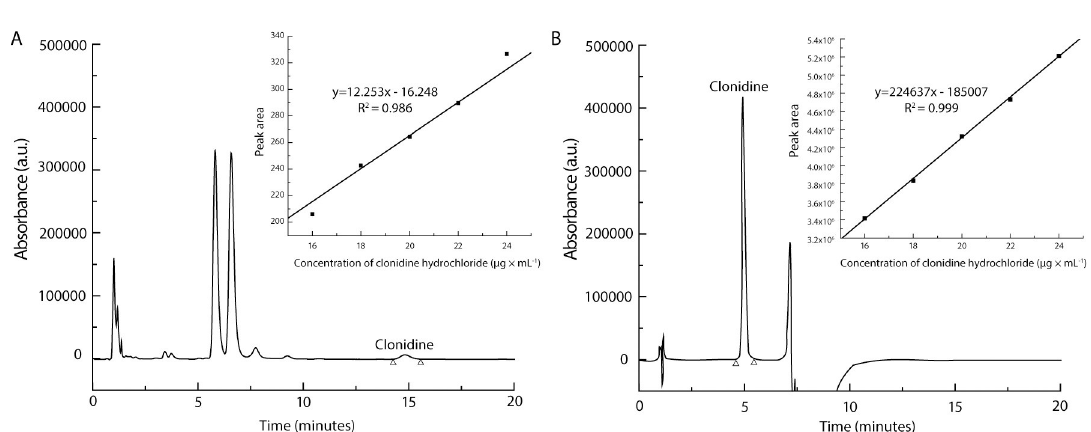
Fig 5. Evolution of the chromatographic analysis and its improvement over the quantification of clonidine hydrochloride. Chromatograms and calibration curves (inset) obtained (A) without SPE and (B) with SPE.